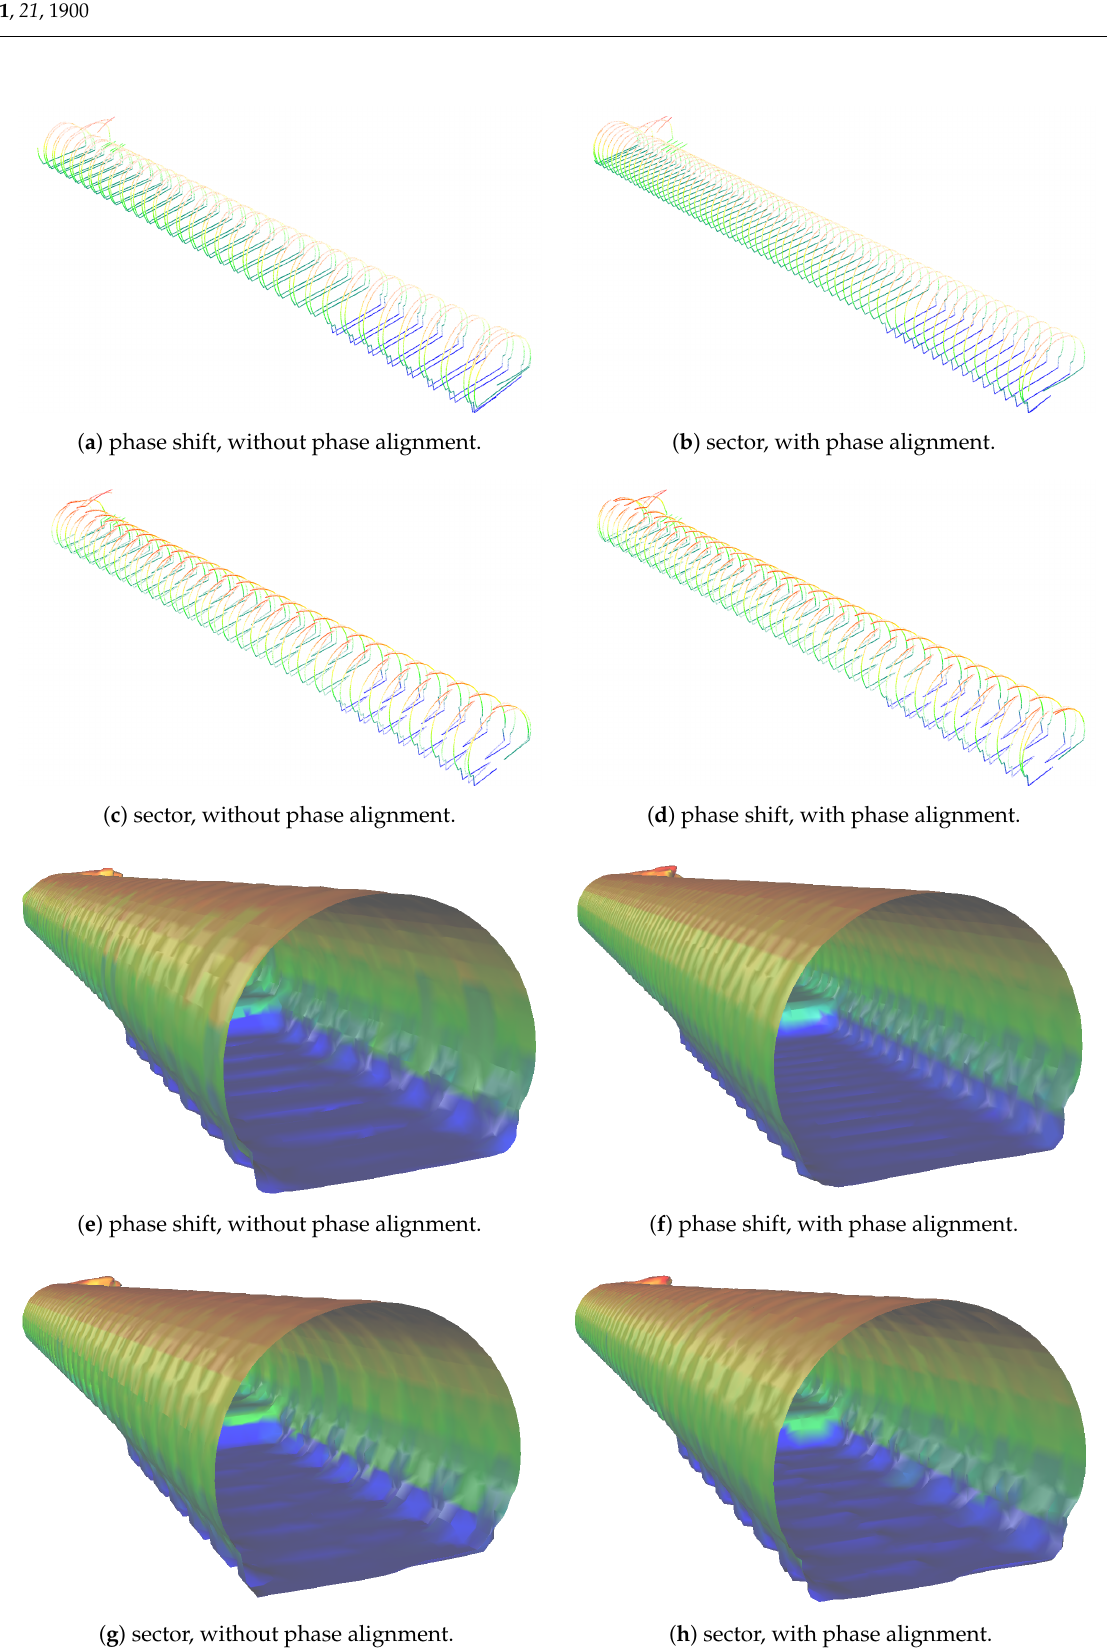
Figure 12. Comparison of the two configuration of sensors with respect to phase alignment. Figure 12e,f highlights the influence of correct phase in the phase shift approach, while the same is not true for sector offset, which presents inferior results but does not seem to suffer influence when ignoring phase alignment (see Figure 12g,h). We compare the